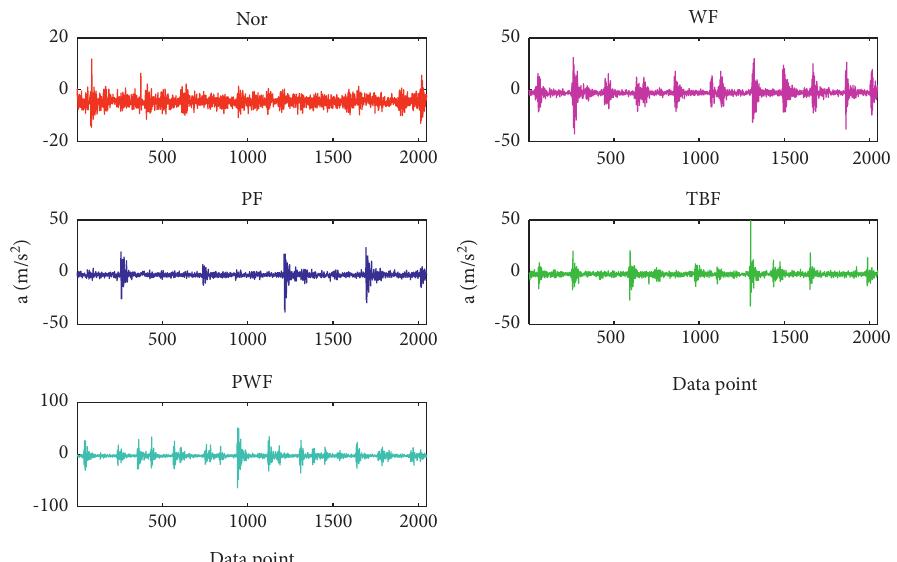
Figure 17: The vibration waveform of gearbox under five fault conditions.